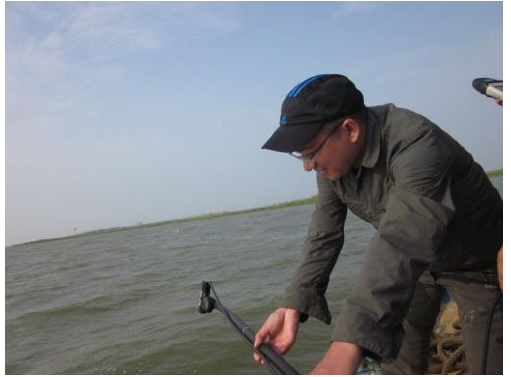
Figure 1. The viewing geometry of 50° from nadir ( θ v ) and 135° from the sun ( φ v ) in the above-water method [13].